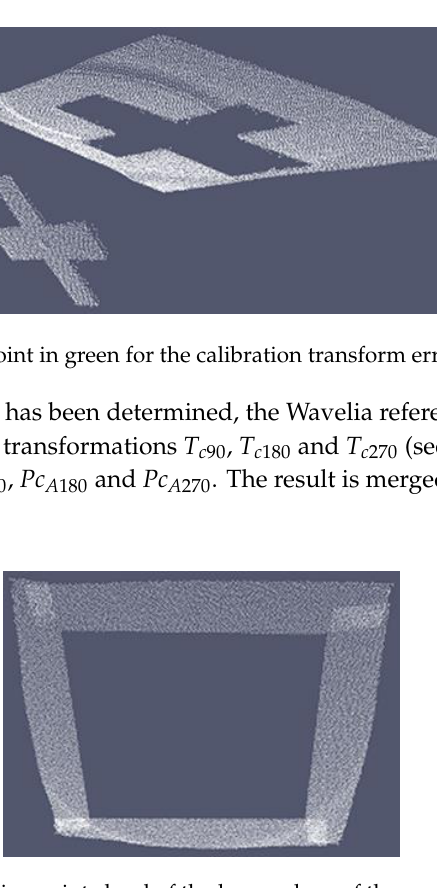
Figure 9. Cumulative point cloud of the lower plane of the examination table.